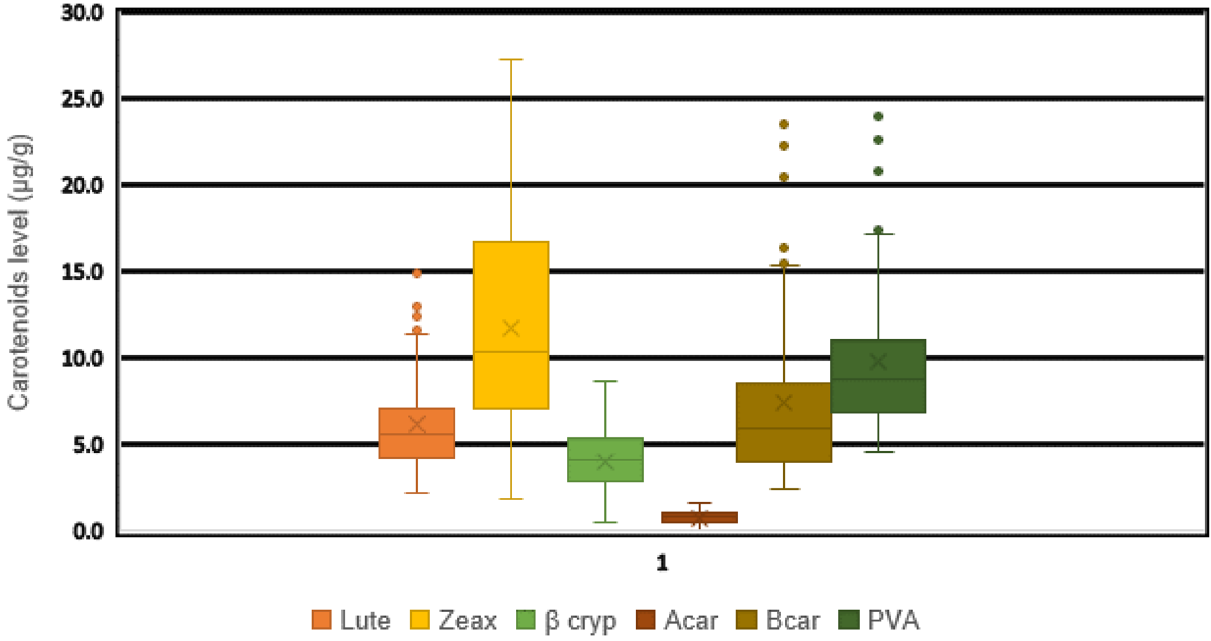
Figure 3. Distribution of the different carotenoids across the S4 inbred lines derived from HGA.